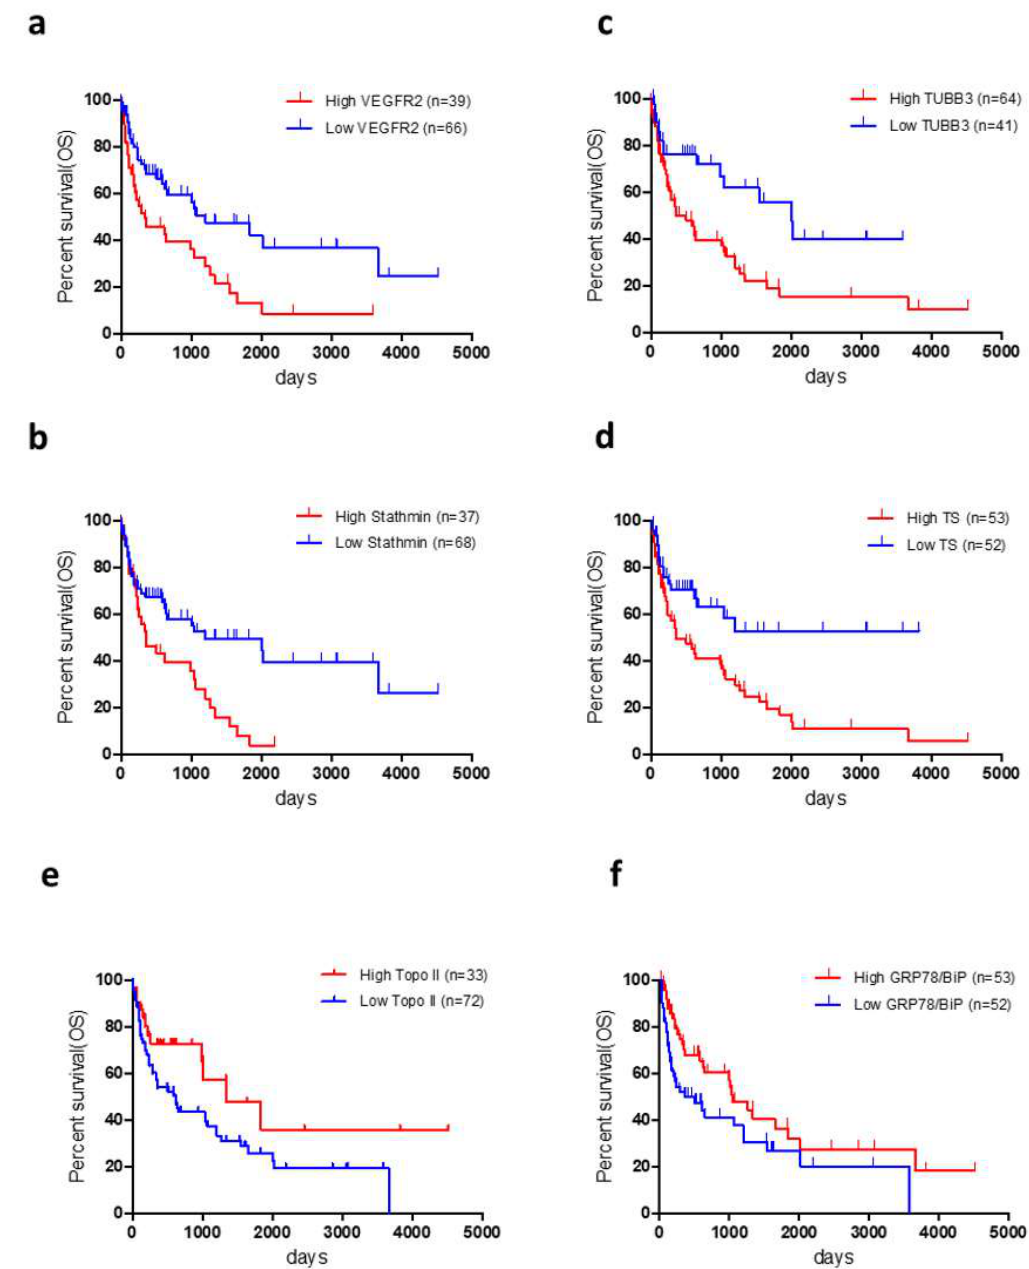
Figure 2. Kaplan–Meier survival curves for patients exhibiting differential marker levels. Kaplan-Meier plots showing OS according to ( a ) VEGFR2 level (VEGFR2-high/-low) [VEGFR2-high, median = 352 days; VEGFR2-low, median = 1209 days (log-rank: p < 0.01)], ( b ) STMN1 level (STMN1-high/-low) [STMN1-high, median = 359 days; STMN1-low, median = 1202 days (log-rank: p < 0.01)], ( c ) TUBB3 level (TUBB3-high/-low) [TUBB3-high, median = 361 days; TUBB3-low, median = 2010 days (log-rank: p < 0.01)], ( d ) TS level (TS-high/-low) [TS-high, median = 361 days; TS-low, median = not reached (log-rank: p < 0.01), ( e ) Topo-II level (Topo-II -high/-low) [Topo-II -high, median = 1338 days; Topo-II-low, median = 615 days (log-rank: p < 0.05)], and ( f ) GRP78/BiP level (GRP78/BiP-high/-low) [GRP78/BiP-high, median = 1047 days; GRP78/BiP-low, median =507 days (log-rank: p = 0.04)]. OS, overall survival; STMN1, stathmin 1; Topo-II, topoisomerase II; TS, thymidylate synthase; TUBB3, tubulin β3 class III; VEGFR2, vascular endothelial growth factor receptor 2.